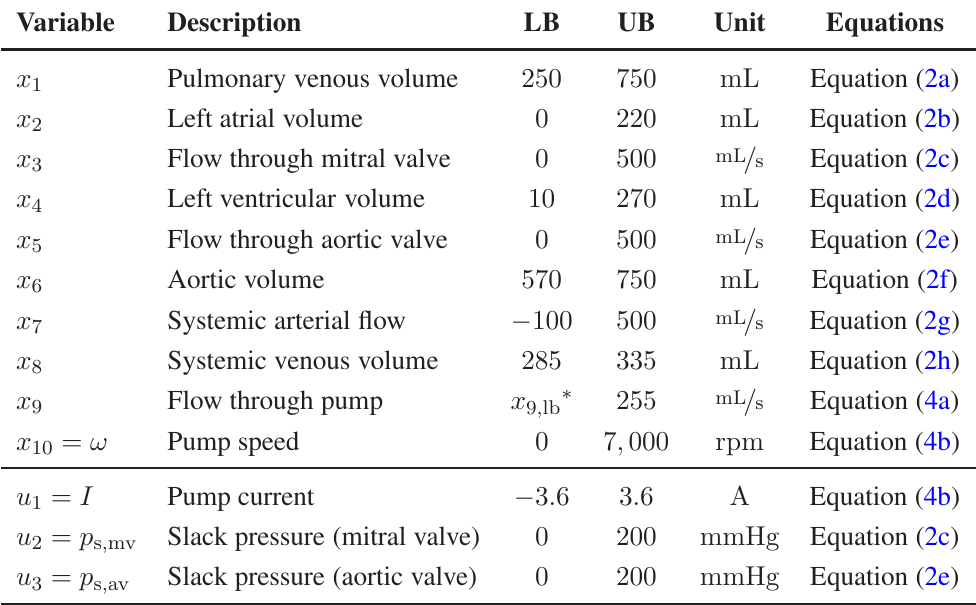
Table A1. Description of the state variables and the inputs of the reduced circulation model and the pump, including their lower (LB) and upper (UB)